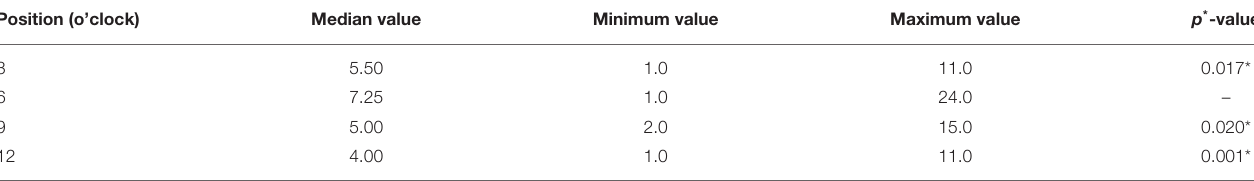
TABLE 1 | Distribution of nerve plexuses (count) in various positions of the penis. Position (o’clock) Median value Minimum value Maximum value p * -value 3 5.50 1.0 11.0 0.017*